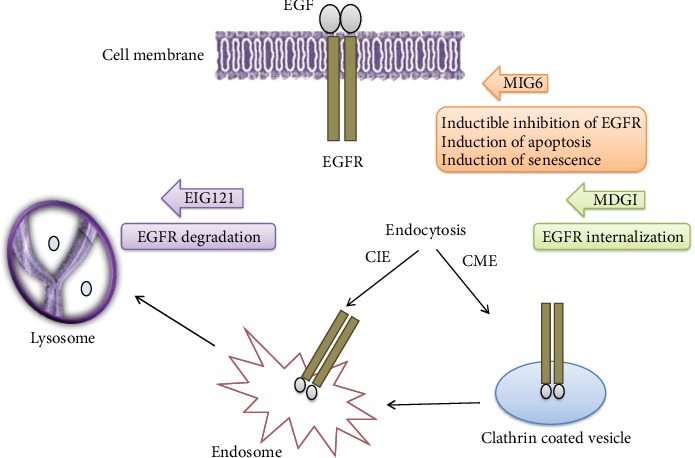
EGFR posttranslational regulators MDGI, MIG6, and EIG121 signalling pathways. EGF binding causes ligand-receptor complex to internalize via clathrin. Liganded EGFR monomers dimerize and translocate along the plasma membrane until association with a membrane domain that is enriched with clathrin on the intracellular face. This domain invaginates to initiate a clathrin-coated pit, which pinches off to form a clathrin-coated vesicle. Clathrin is shed from this primary vesicle to produce an intermediate vesicle that fuses with and delivers EGF/EGFR complex to an early endosome. The early endosome then matures into a late endosome and delivers cargo to lysosome.